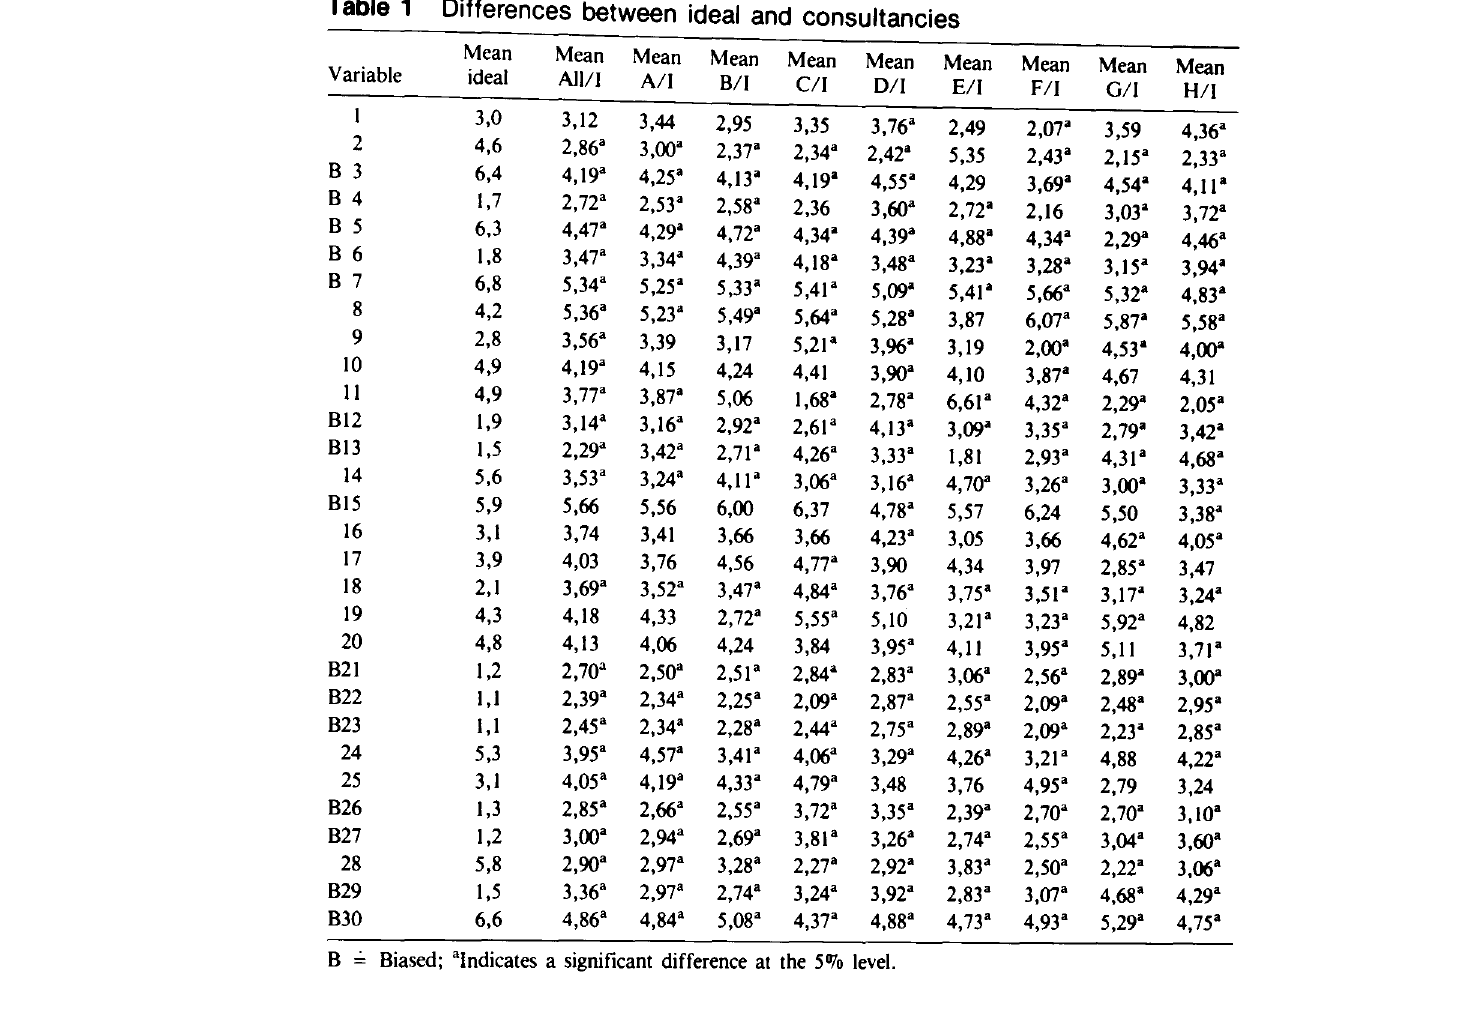
Differences between ideal and